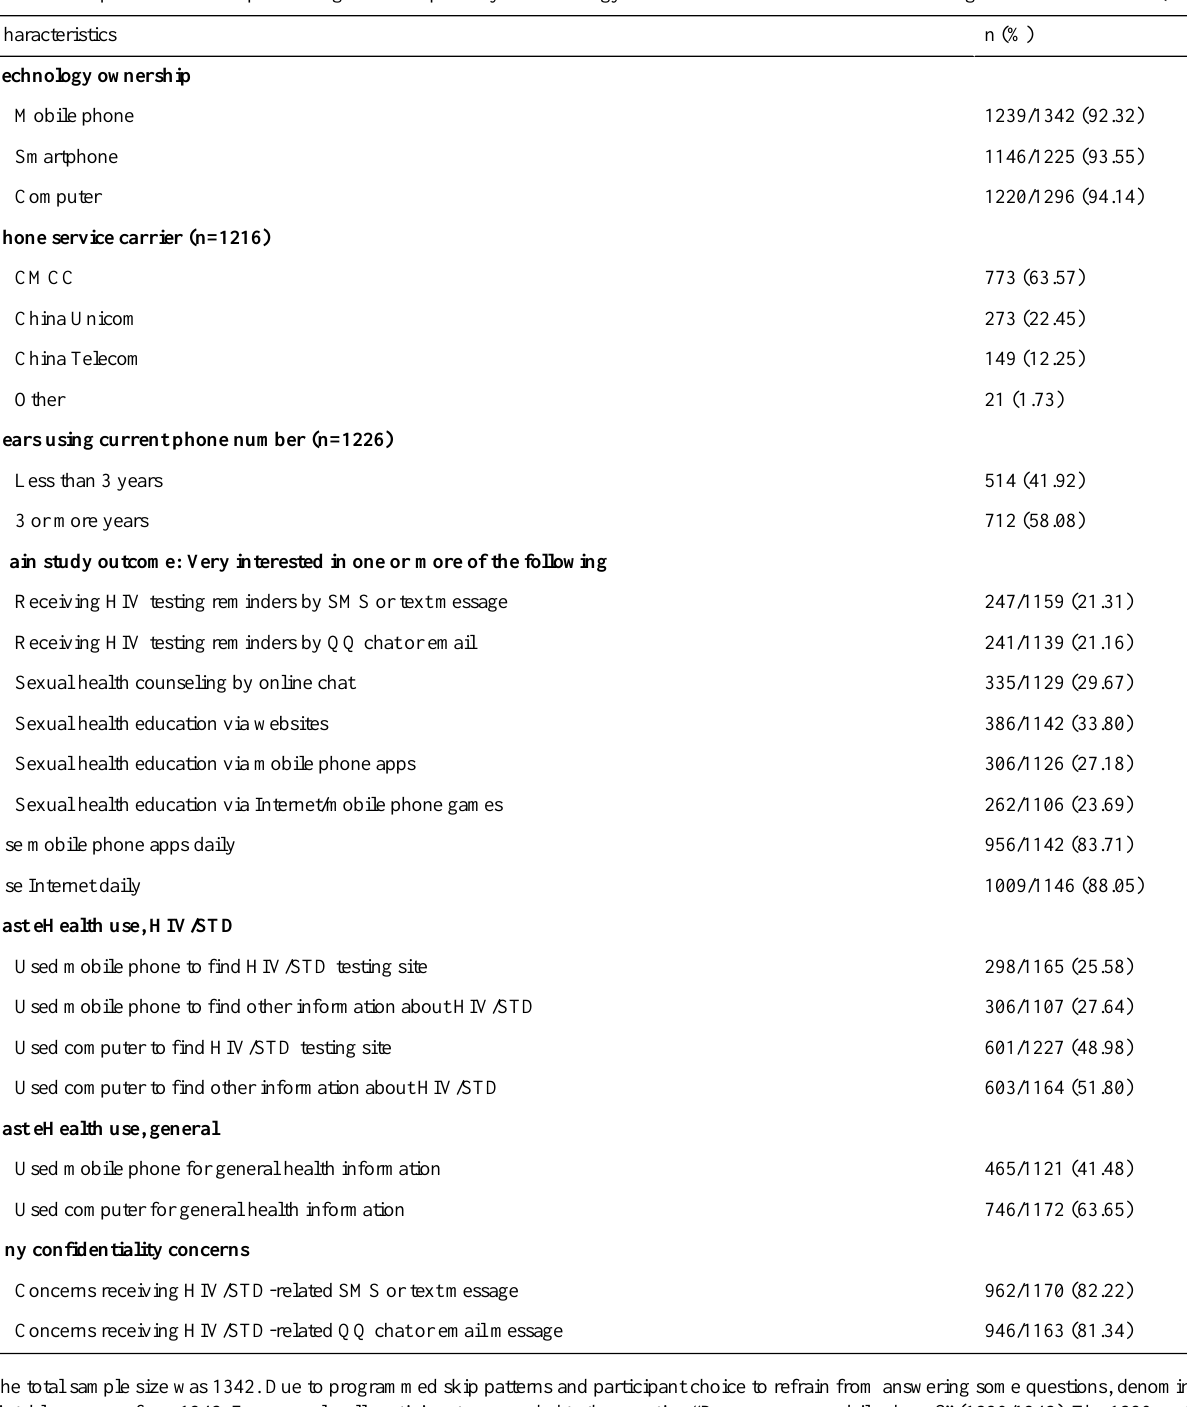
Table 2. Computer and mobile phone usage and acceptability of technology-based sexual eHealth intervention among 1342 MSM in China (N=1342 a